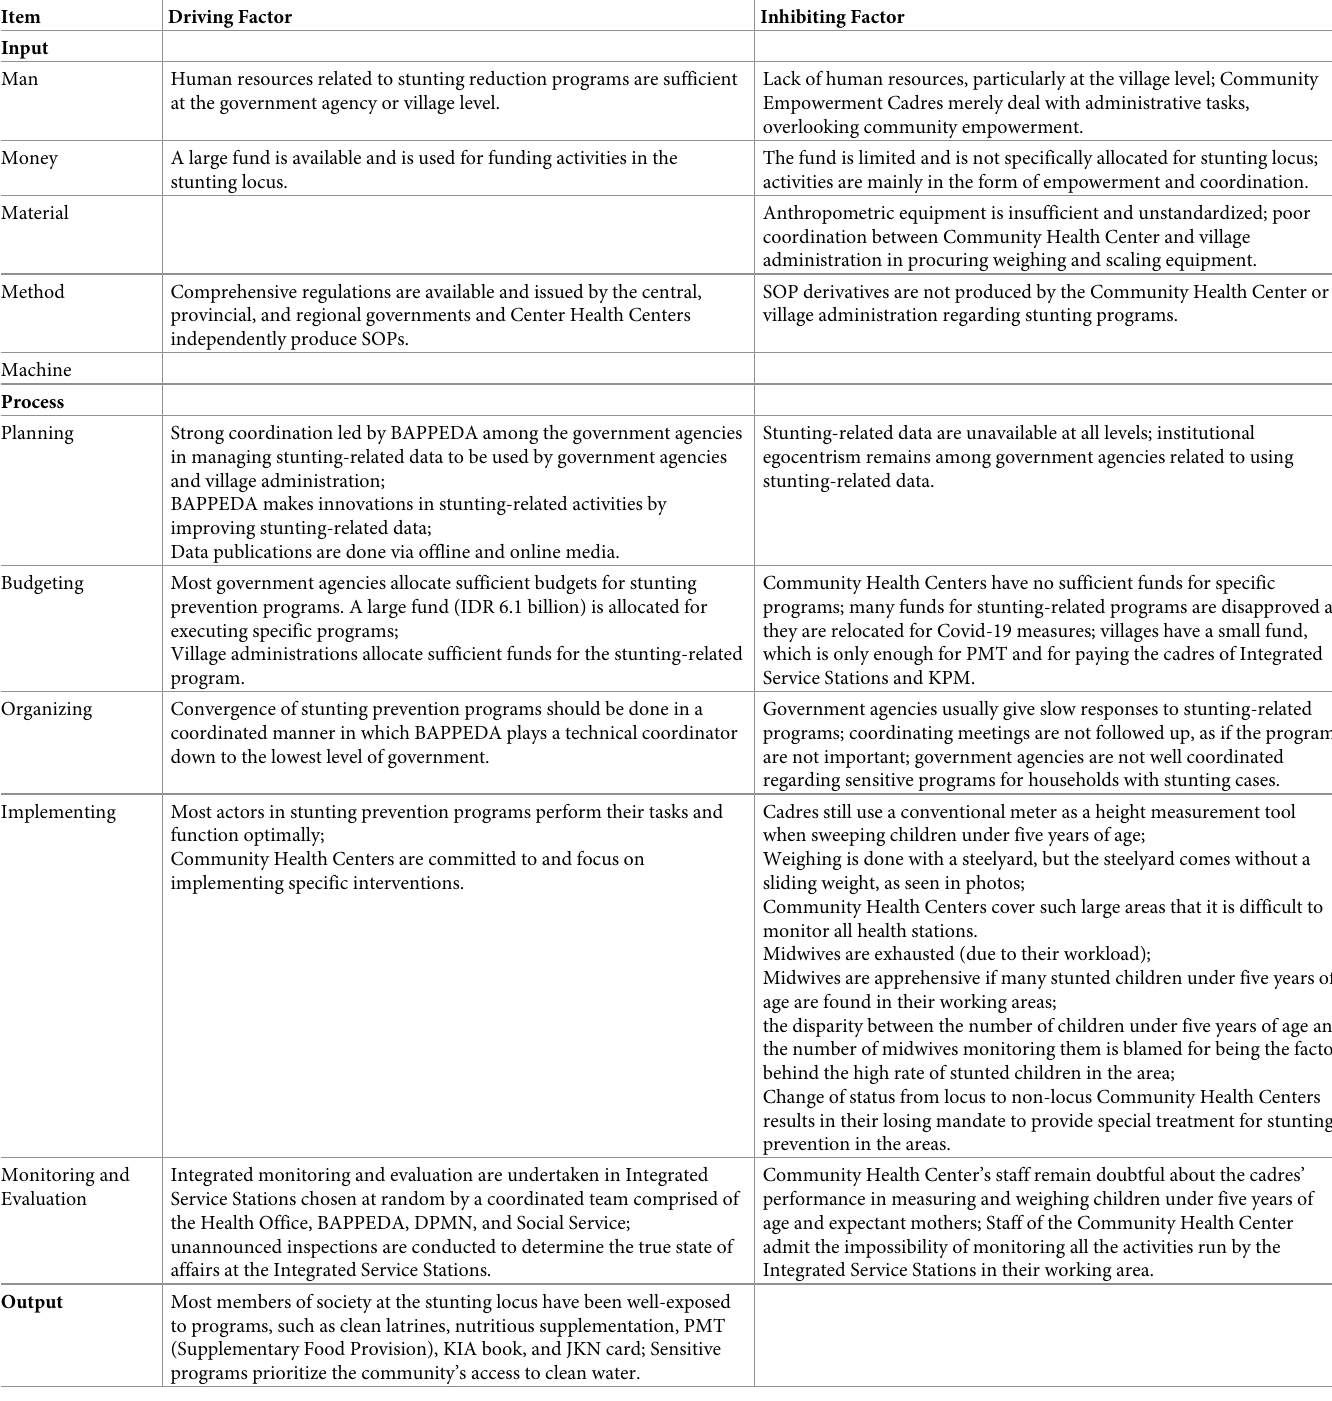
Table 4. Driving and inhibiting factors of stunting reduction